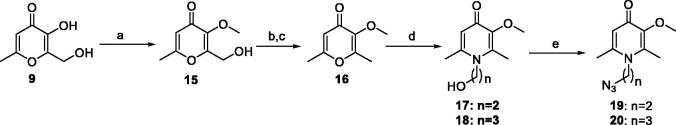
The synthetic route of intermediates 19 and 20. Reagents and conditions: (a) Acetone, CH3I, K2CO3, r.t., 4 h, 93%; (b) CH2Cl2, SOCl2, r.t., 4 h, 87%; (c) H2O, Zn, HCl, 70 °C, 72%; (d) MeOH:H2O = 1:1, NH2(CH2)nOH, NaOH, reflux, 12 h, 77%–79%; (e) DMF, NaN3, Ph3P, CBr4, r.t., 1 h, 79%–81%.